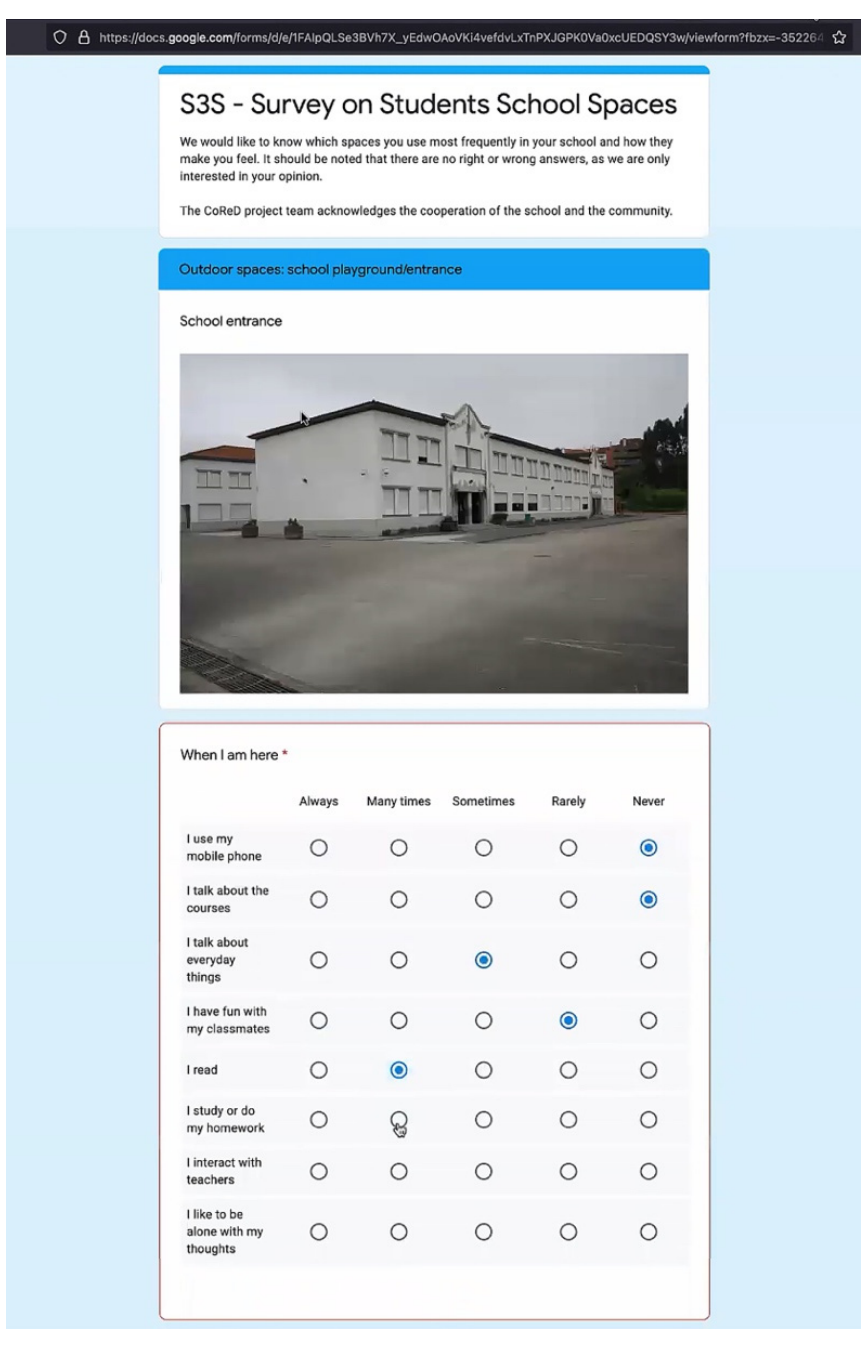
Figure 1 . Questionnaire